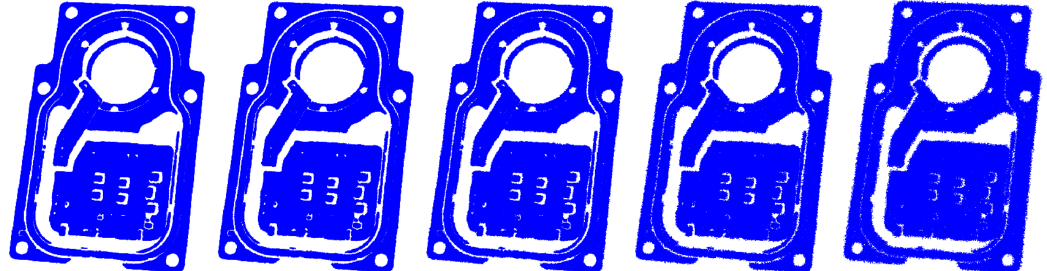
Figure 11. Gaussian noise is added to the point cloud in the M 2 point cloud sample; the standard deviations from left to right are 0.1, 0.2, 0.3, 0.4, and 0.5.